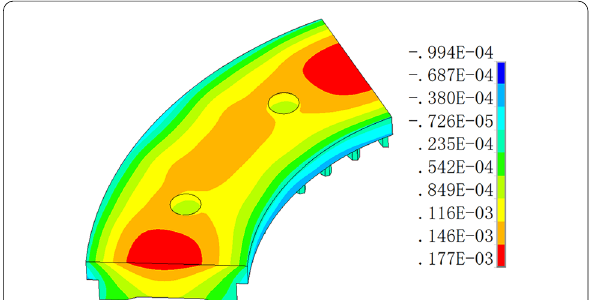
Figure 11 Axial deformation contour of brake disc (m)